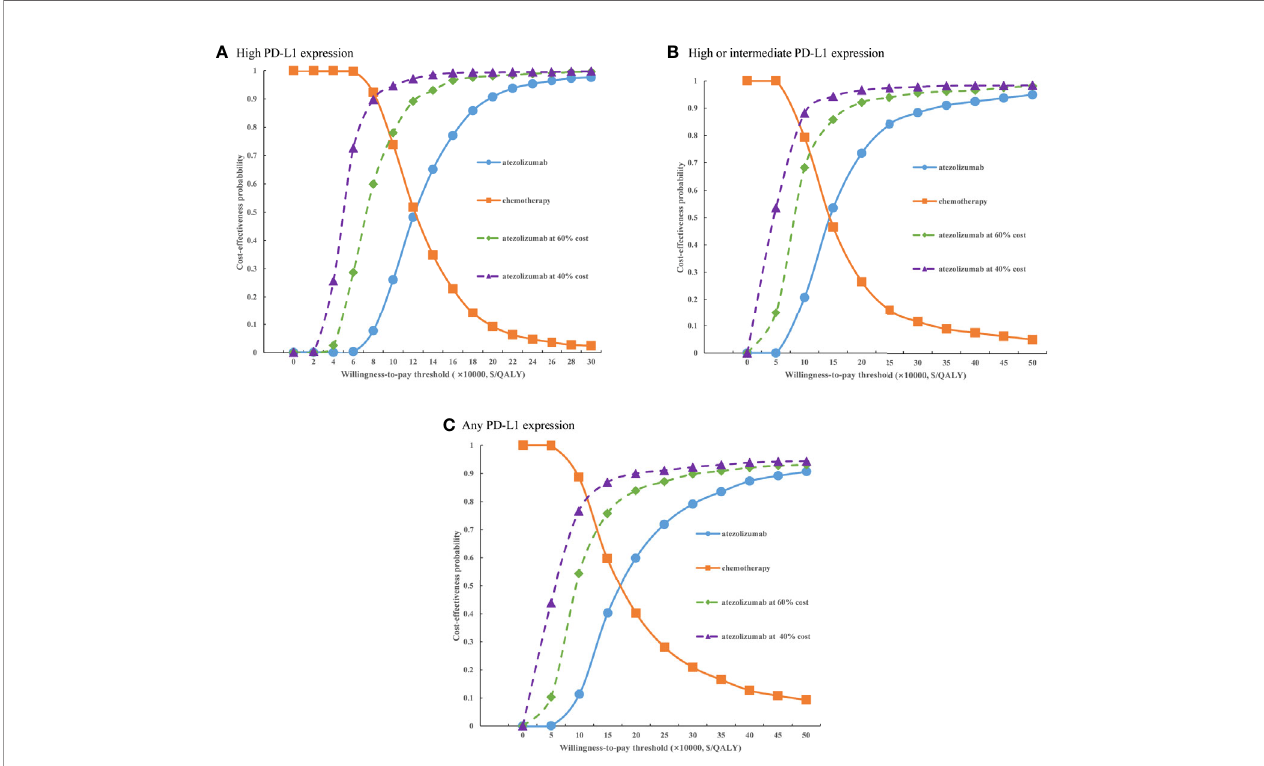
FIGURE 5 | Cost-effectiveness acceptability curves of atezolizumab versus chemotherapy when the PAP was not available for (A) high PD-L1 expression populations, (B) high or intermediate PD-L1 expression populations and (C) any PD-L1 expression populations. PD-L1, programmed death ligand